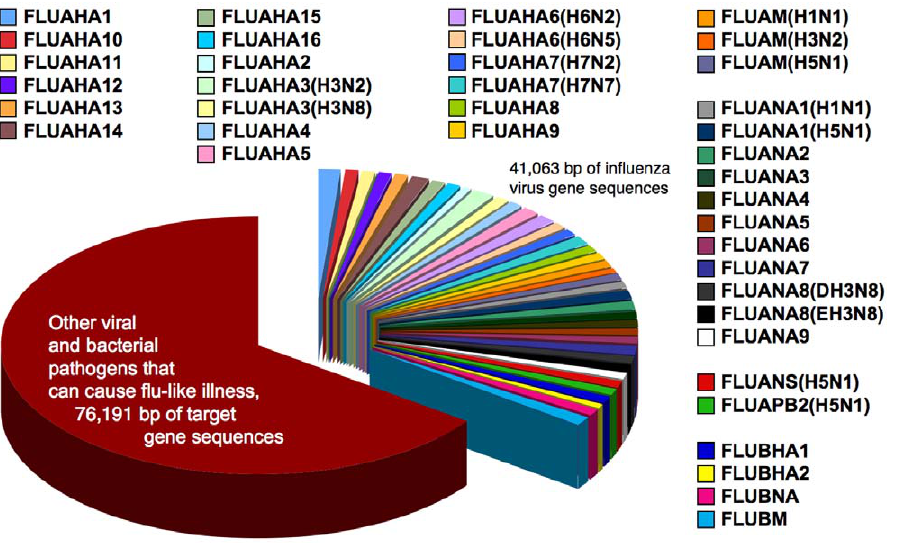
Figure 1. Influenza virus gene targets of the RPM-Flu assay. The TessArray RPM-Flu 3.1 allocates 40 detector tiles (41,063 bp) that represent influenza virus hemagglutinin genes (16 type A and 1 type B) and neuraminidase genes (9 type A and 1 type B), matrix genes (3 type A and 1 type B), and also the conserved NS and PB2 genes of avian influenza virus strain A/H5N1. The remaining 76,191 bp of re-sequencing capability on the microarray (as large red wedge) are distributed among 2 control detector tiles and 142 detector tiles that represent genes of other pathogens that may cause ‘‘flu-like’’ respiratory illness in humans. These other pathogens include viruses (adenovirus, enterovirus and rhinovirus, coronavirus, herpesvirus, measles virus, metapneumovirus, parainfluenzavirus, respiratory syncytial virus, rubella virus, and poxvirus [variola]) and bacteria ( Bacillus [anthracis] , Bordetella , Chlamydophila and Chlamydia , Corynebacterium , Francisella , Haemophilus , Klebsiella , Legionella , Moraxella , Mycobacterium , Mycoplasma , Neisseria , Pseudomonas , Streptococcus , Staphylococcus and Yersinia